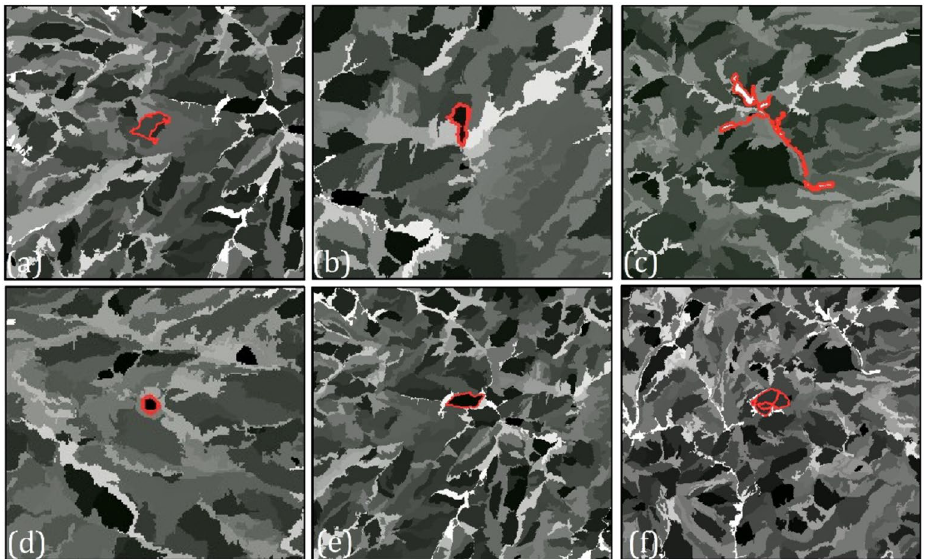
Figure 5. Some samples from object-based features and targeted landforms, including: ( a ) GLCM Mean (volcanic tuff), ( b ) GLCM SD (glacial cirque), ( c ) length/width (glacial valley), ( d ) shape index (caldera), ( e ) density (suspended valley), and ( f ) shape index (volcanic cone).